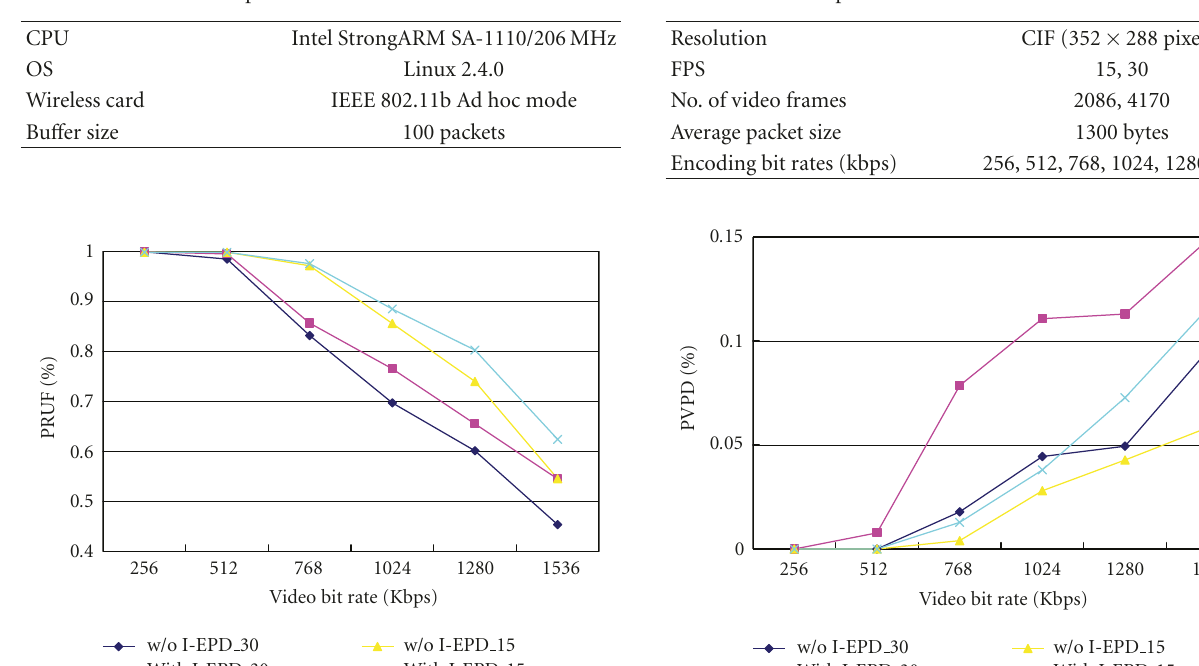
Table 2: Specifications of MPEG-4 video streams.